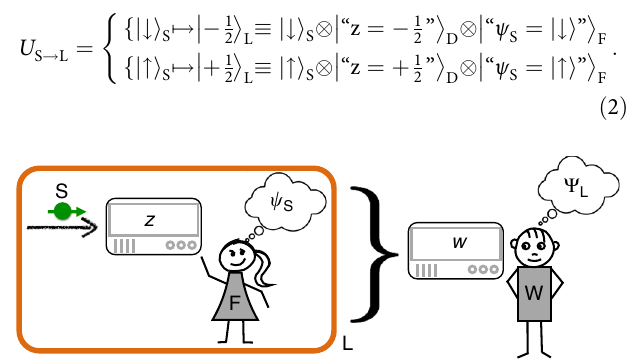
Fig. 1 Wigner ’ s and Deutsch ’ s arguments. Agent F measures the spin S of a silver atom in the vertical direction, obtaining outcome z . From F ’ s perspective, S is then in one of the two pure states ψ S given in (1). Agent W, who is outside of F ’ s lab, may instead regard that lab, including the agent F, as a big quantum system L (orange box). Wigner argued that, having no access to z , he would assign a superposition state Ψ L of the form (3) to L 2 . Deutsch later noted that agent W could in principle test this state assignment by applying a carefully designed measurement to L